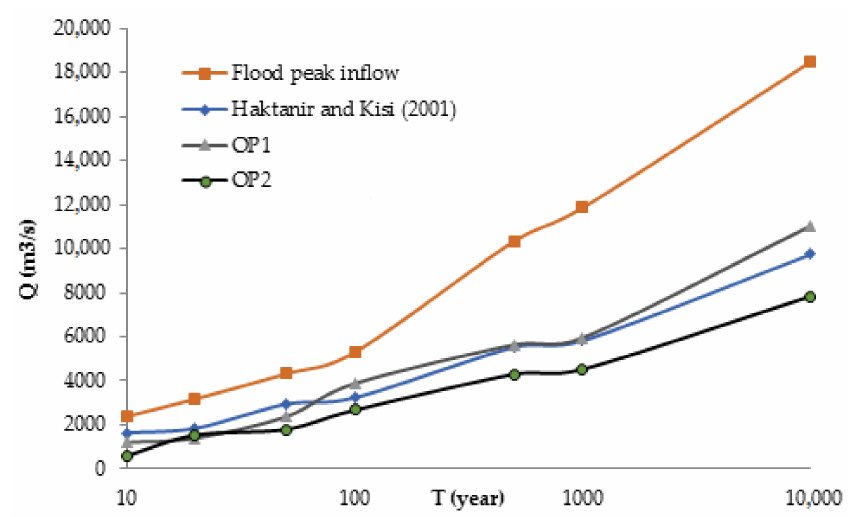
Figure 3. Comparison of flood peak with different return periods for different methods ( n =